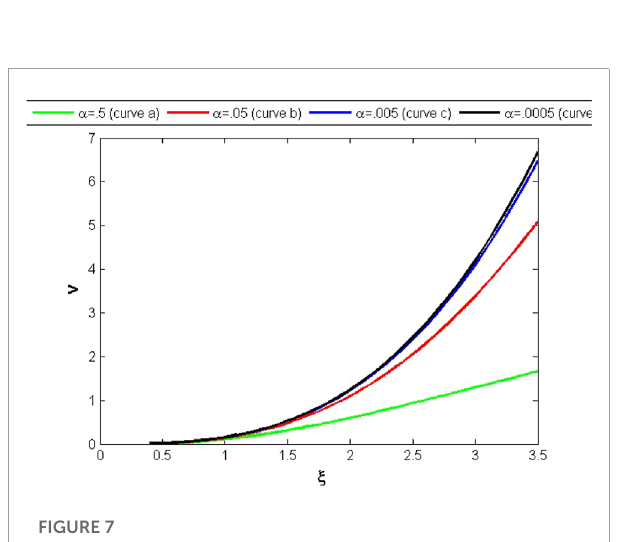
FIGURE 7 v ( ξ ) curves.